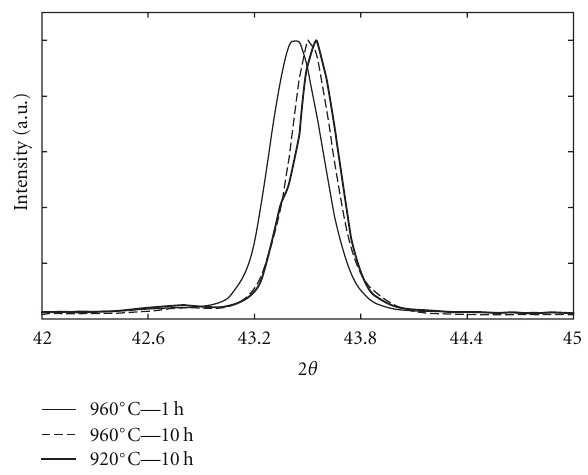
Figure 4: XRD pattern showing angular displacement of the (111) matrix peak as function of ageing